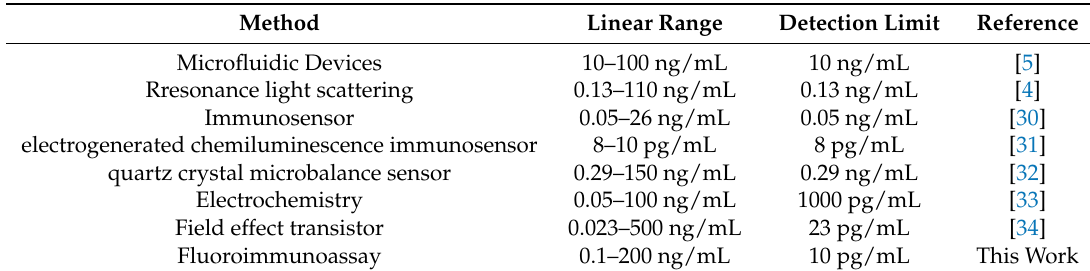
Table 1. Performance comparison of different methods.